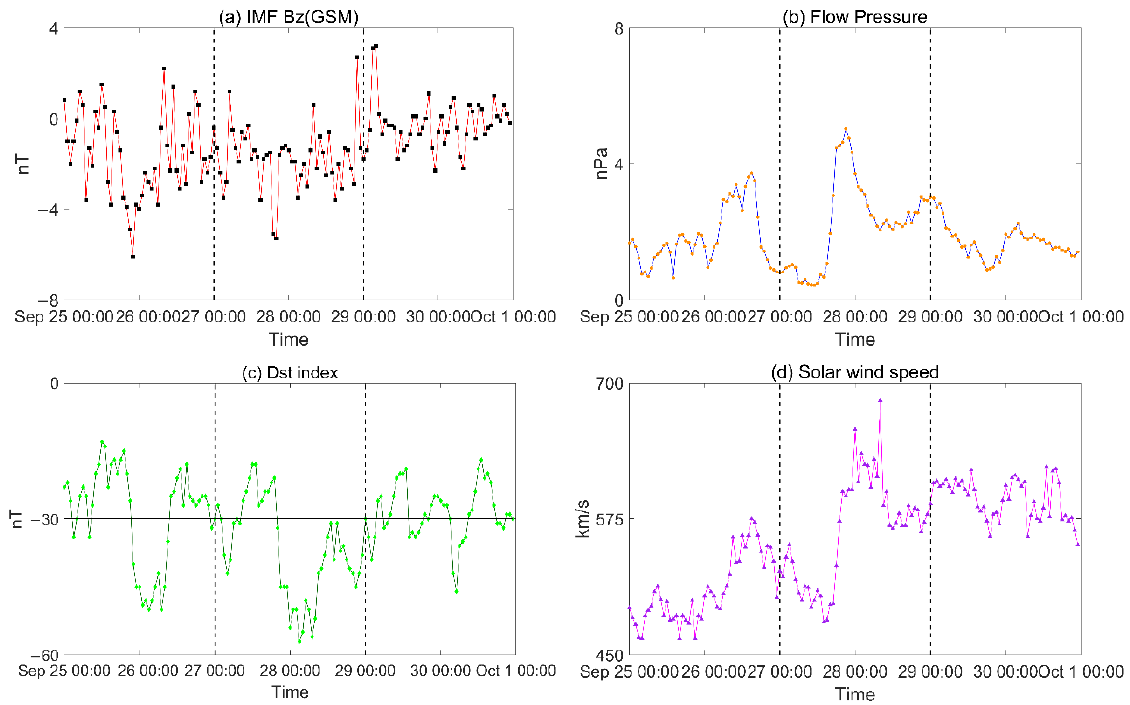
Figure 9. Variation in geomagnetic and solar parameter values during the period 25–30 September 2020, and the two vertical dashed lines denote the start and end moments of the period studied for a moderate geomagnetic storm condition.